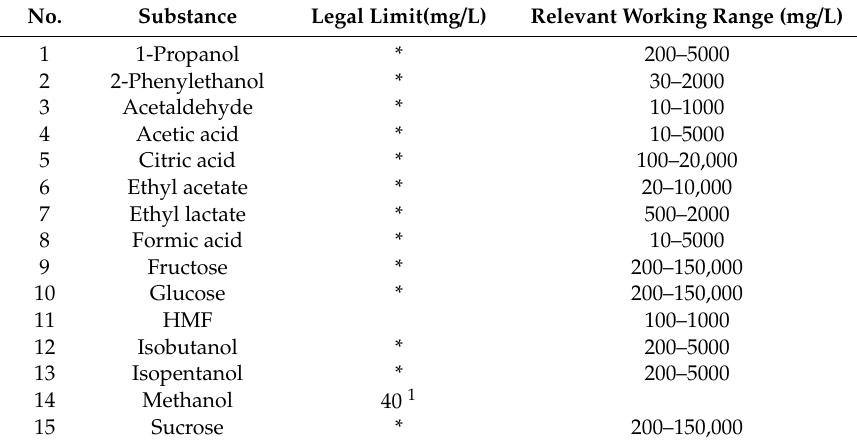
Table 1. Evaluated analytes in spirit